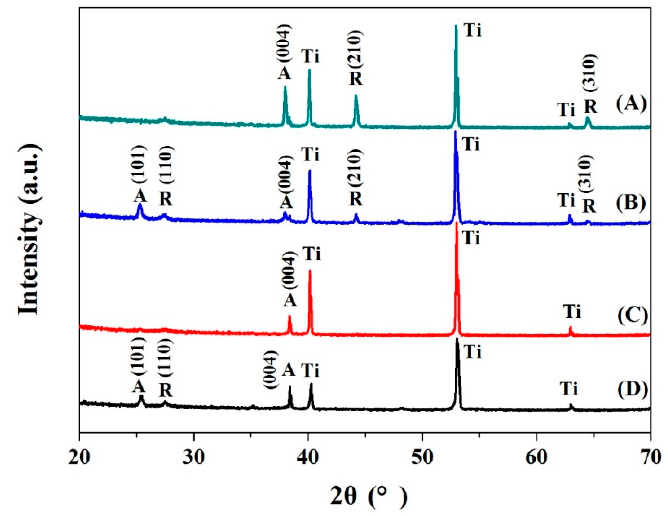
Figure 3. XRD patterns of Mo-doped TiO 2 -nanotube films with following different contents of Mo (A) Mo1.0, (B) Mo0.5, (C) Mo0.25, (D) Mo0; A: anatase, R: rutile, Ti: crystalline phase of Ti.